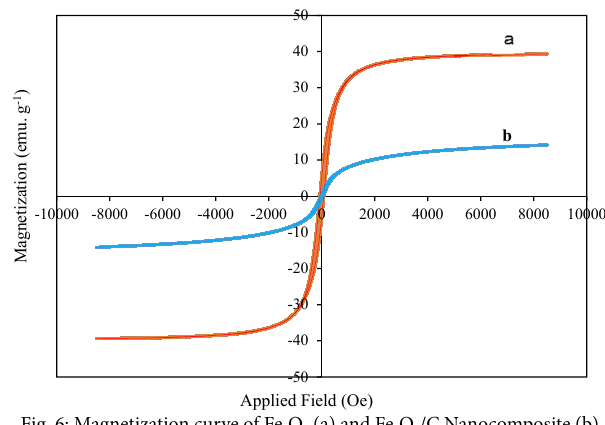
Fig. 6: Magnetization curve of Fe